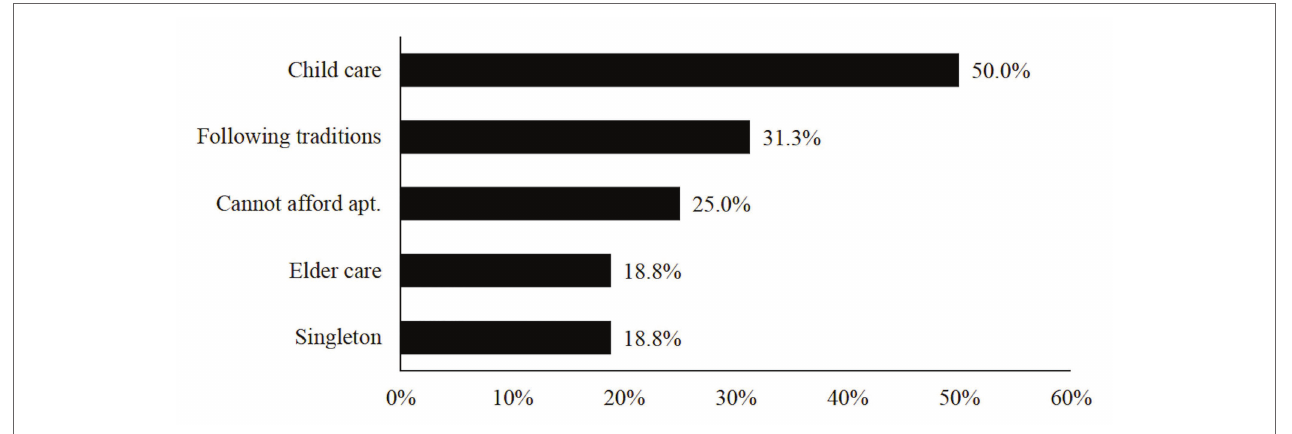
FIGURE 2 | Reasons for co-residence with parents after